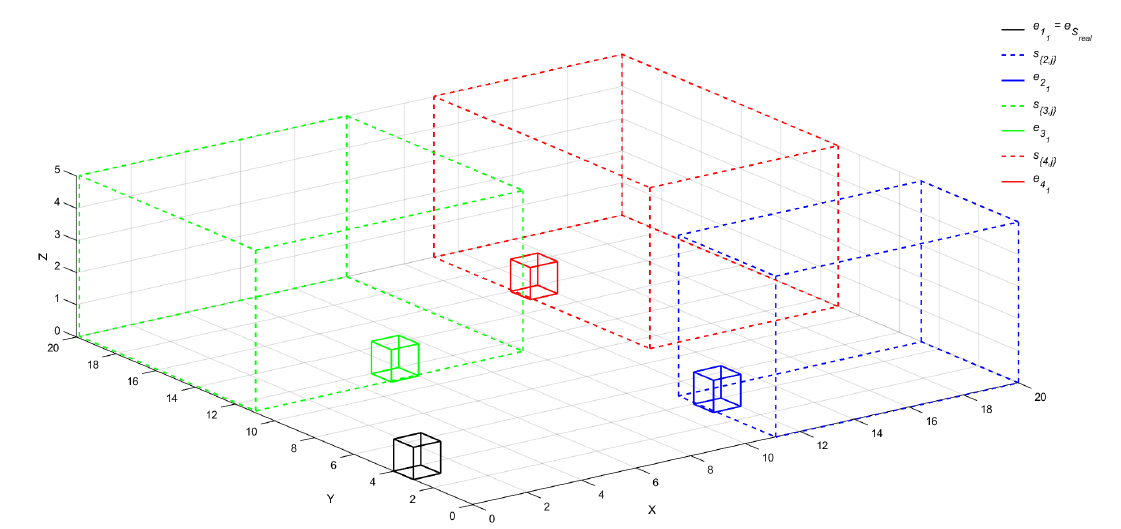
Figure 1. A heterogeneous exploration space S real consisting of three independent